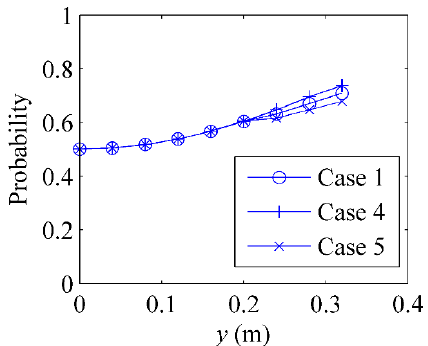
Figure 10. Effect of the standard deviations of vehicle wandering for the probability of being less than 100 µε for vertical compressive strain at different calculation points.